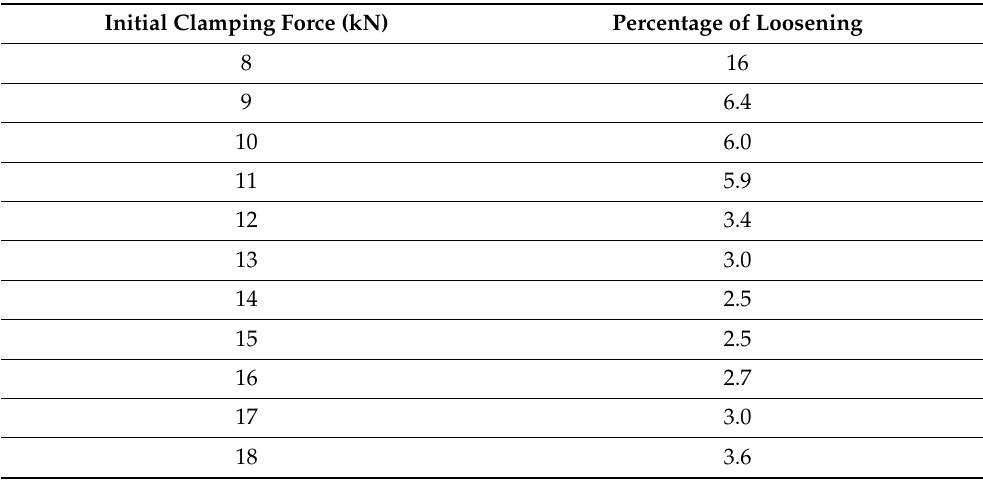
Table 1. Loss of preload affected using different amounts of initial preload application for M16 steel bolt